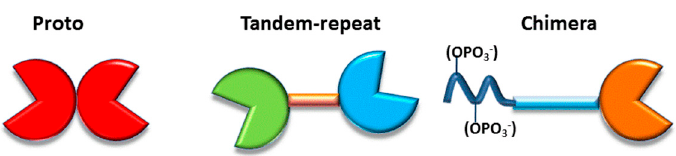
Figure 3. The three basic types of modular design of galectins, as given in the context of other lectins in Figure 2. Proto-type proteins (e.g., galectins-1, -2 and -7) are non-covalently associated homodimers, the vertebrate tandem-repeat-type galectins are formed by two different CRDs connected by a linker (length can vary by alternative splicing and between species) and the chimera-type galectin-3 has an N -terminal tail composed of a peptide with site(s) for Ser phosphorylation and Gly/Pro-rich sequence repeats enabling self-association in the presence of multivalent ligands.